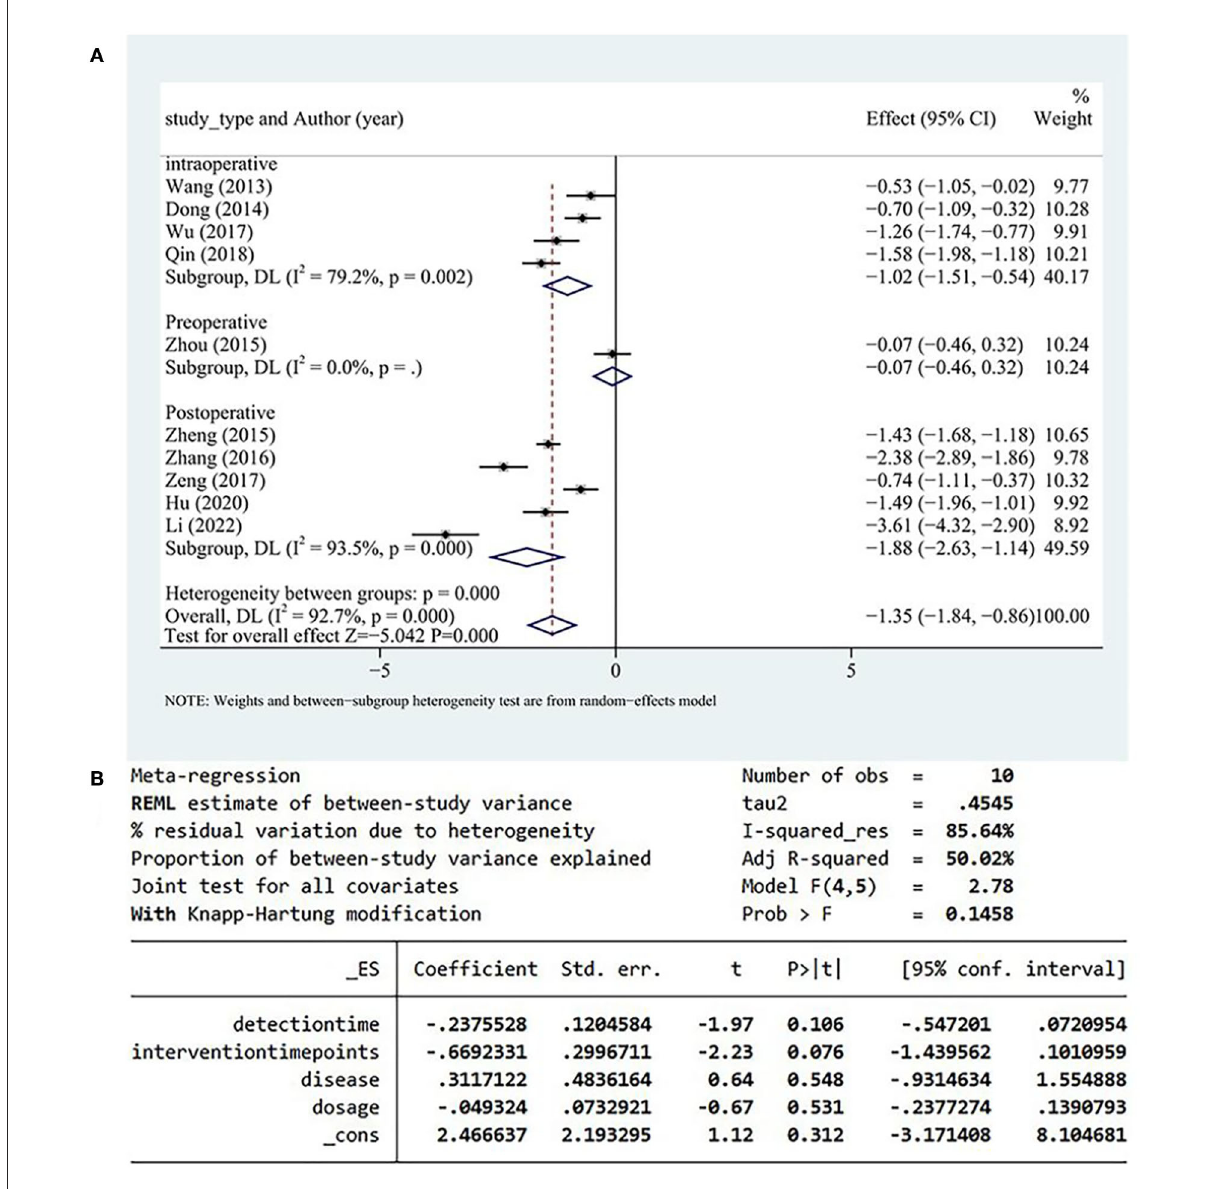
FIGURE6 (A) IL-6 subgroup analysis. (B) Results of meta-regression. IL, interleukin.